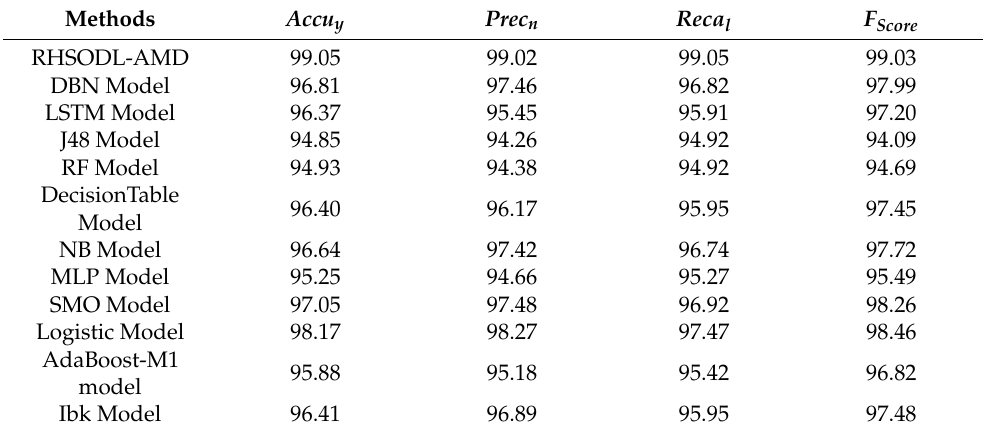
Table 4. Comparative analysis of the RHSODL-AMD algorithm with other approaches [29].